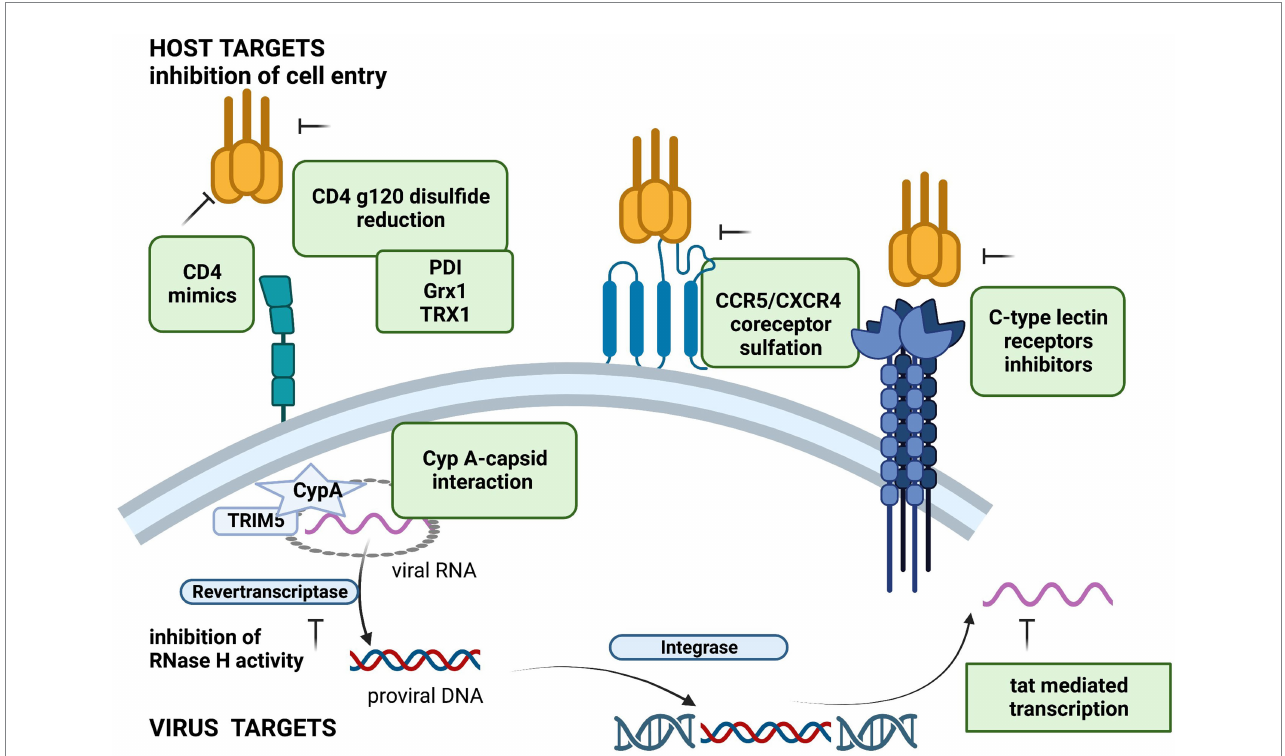
FIGURE 2 Potential host and viral targets for HIV replication inhibition. Created with BioRender.com, with a license to